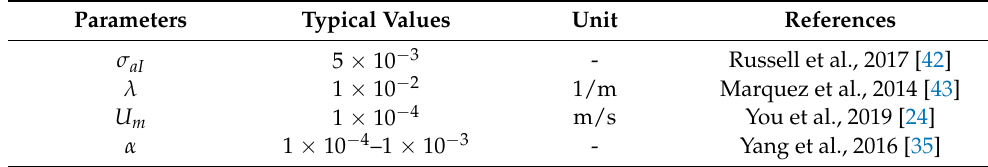
Table 2. Typical values of fines-migration formation-damage coefficients.